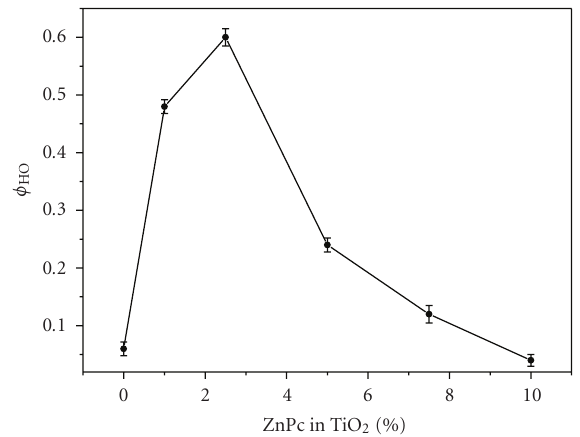
Figure 6: Degradation of the organic load present in 50 L of an aqueous model-e ffl uent containing LSA (160 mg/L). Reactions done proceeded at pH 3, using 100 mg of catalyst per liter of e ffl uent, and addition of 1.00 mL of hydrogen peroxide per liter of e ffl uent. E ffl uent treated using: (1) pure TiO 2 ; (2) TiO 2 /ZnPc 2.5% composite; (3) a recycled TiO 2 /ZnPc 2.5% composite; (4) TiO 2 /ZnPc 2.5% in its second recycle. Inset : Pseudofirst-order rate profiles for the e ffl uent degradation under the above mentioned